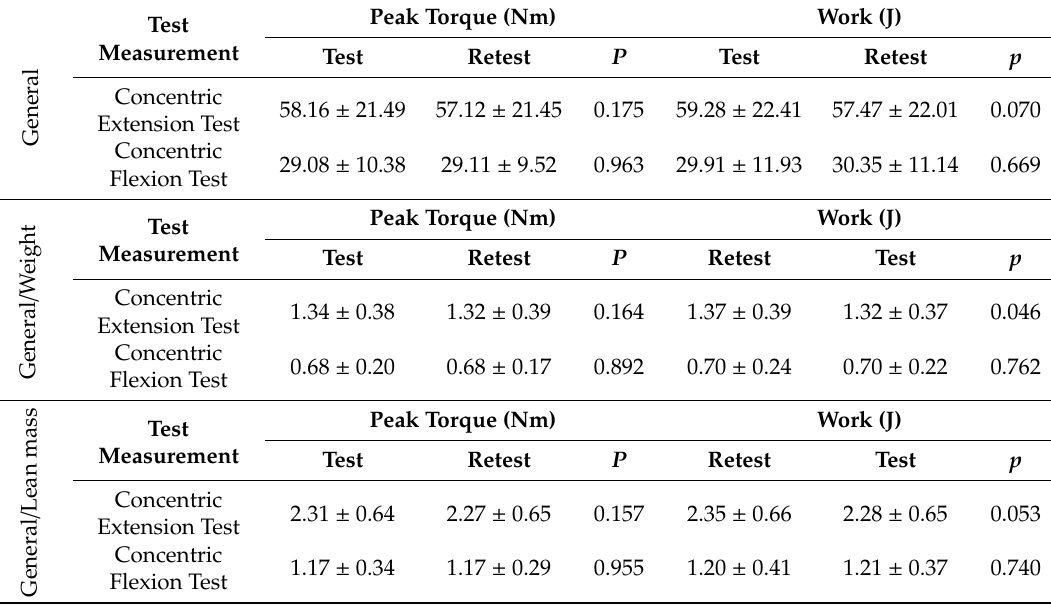
Table 2. Summary of isokinetic peak torque and work at 60 ◦ / s on two occasions ( n =